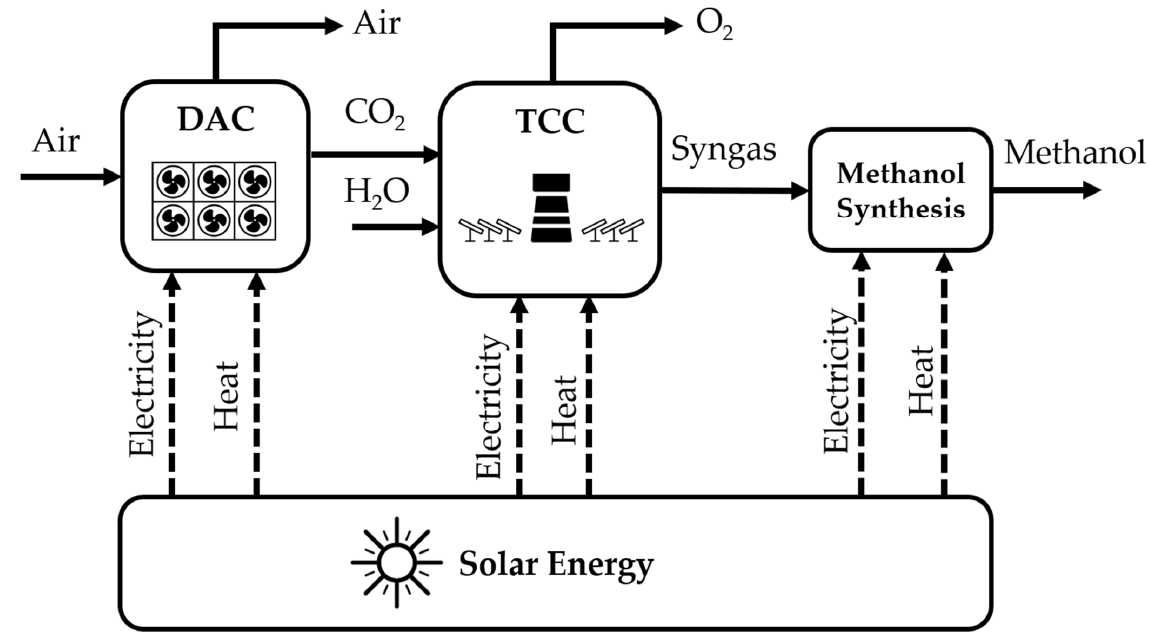
Figure 3. Schematic representation of the overall process. The acronyms DAC and TCC stand for direct air capture and thermochemical cycle, respectively.